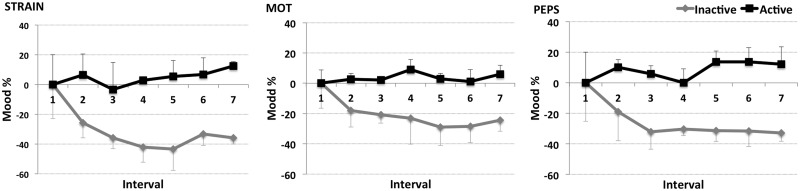
Mood results.Percentage changes from interval 1 of the dimension perceived psychological strain (left), perceived motivational state (middle), and perceived physiological state (right) for the inactive (grey) and the active (black) group in the course of interval 1 to 7 (x-axis). The bar graphs on the right show the mood values at interval one for both groups. Displayed are mean values plus/minus standard deviations.